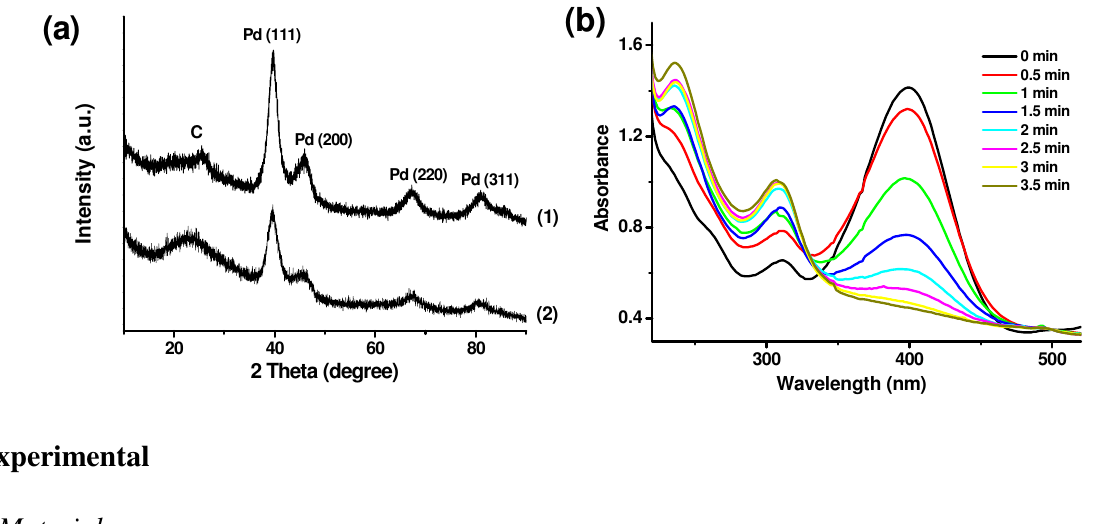
Figure 10. (a) XRD pattern of oMWCNT/Pd (1) and GO/Pd (2). (b) Successive UV-vis spectra for the reduction of 4-nitrophenol into 4-aminophenol with the oMWCNT/Pd